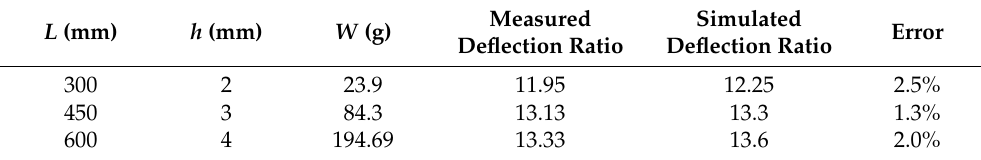
Table 5. Experimental and numerical simulation results